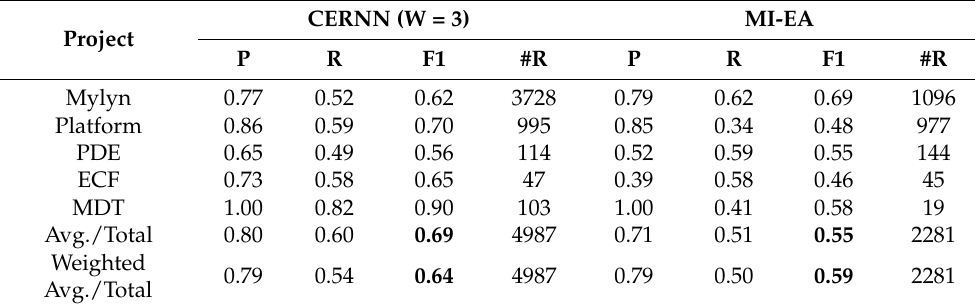
Table 4. Comparison of the recommendation accuracies of CERNN (W = 3) and MI-EA when stopping recommendations if the first edit is found to be